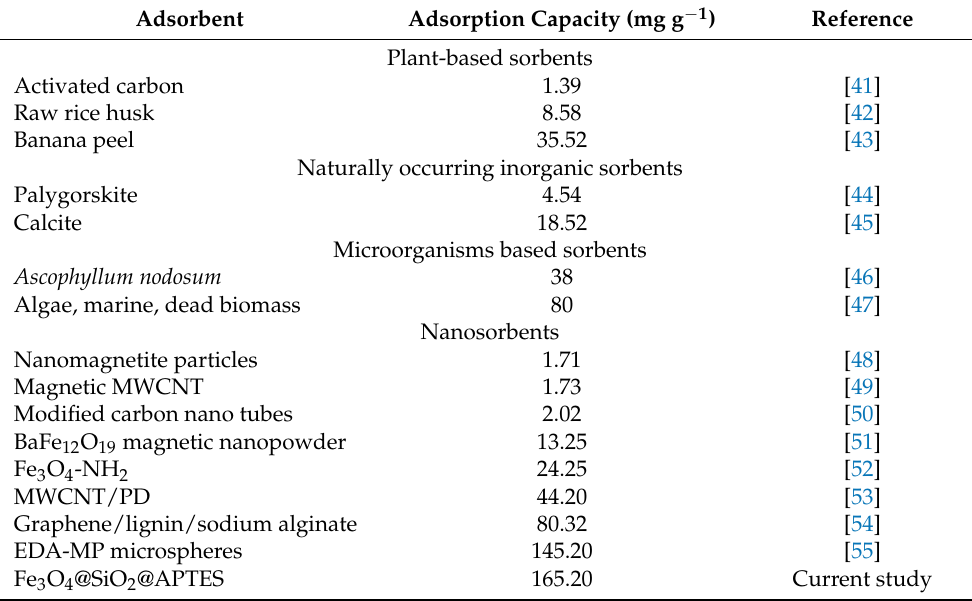
Table 5. Comparison of adsorption capacity for reported sorbents to the developed